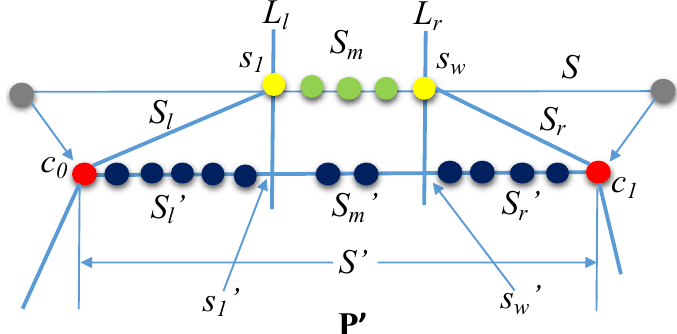
Figure 14. Example configuration of side of P and side of P (cid:48) for Stage 1.5. Recall that Stage 1.5 moves the robots on S (cid:48) S r , respectively, and colors them side